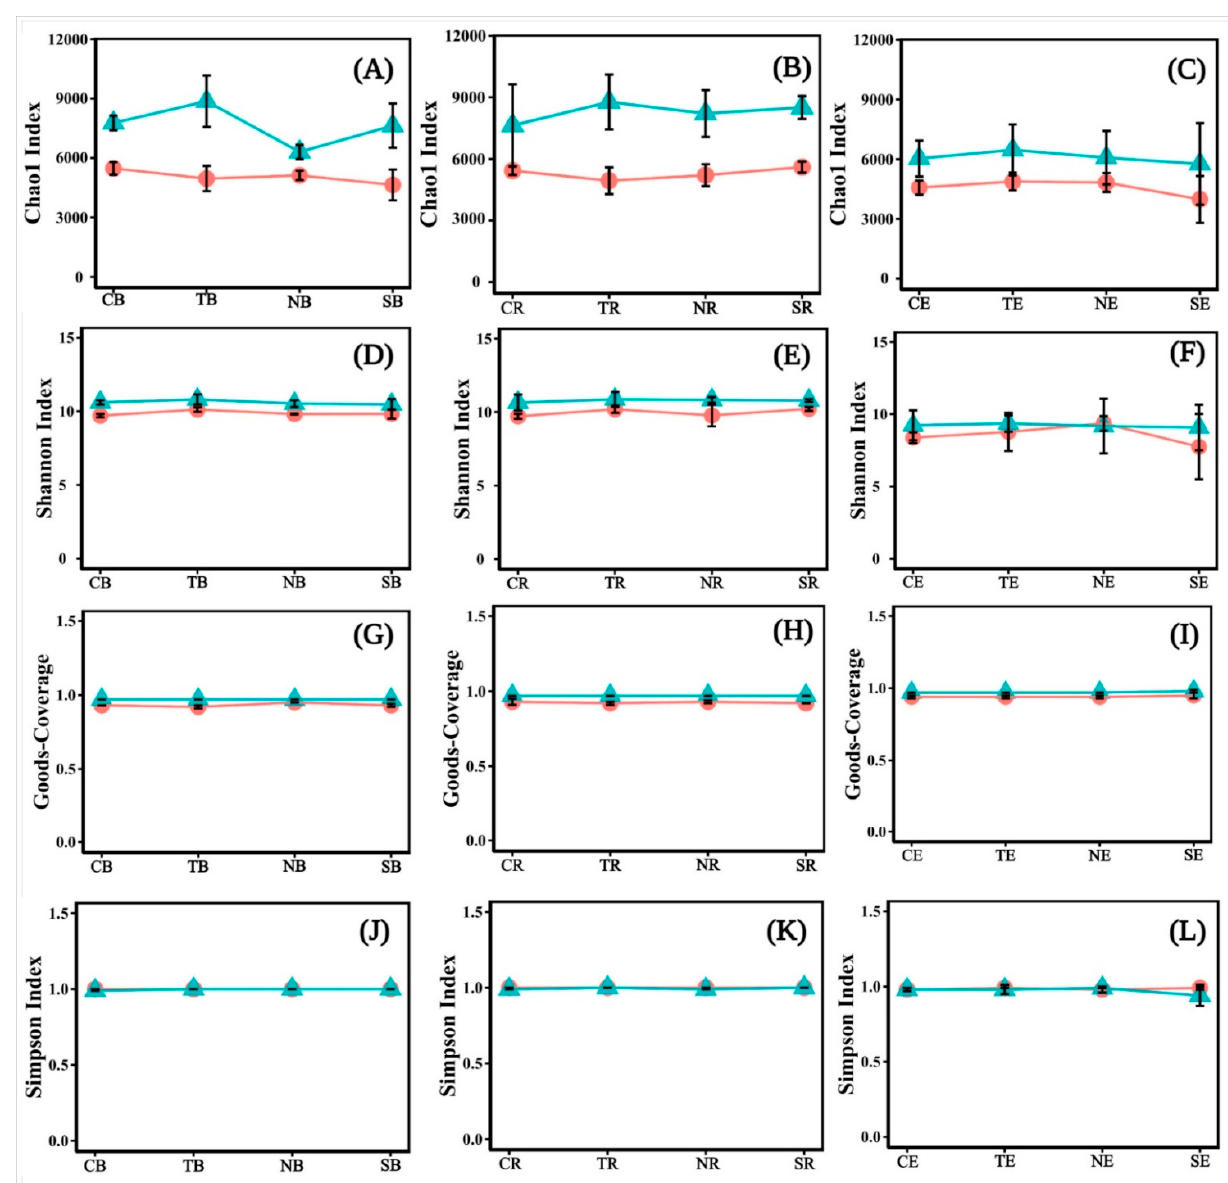
Figure 6. The diversity and richness of bacterial communities were shown with line charts for different emergence phases (T1 for early phase and T2 for late phase) within the riparian zones of the Three Gorges Dam Reservoir, China. The values of bacterial communities were shown by Chao1 Index ( A – C ), Shannon Index ( D – F ), Goods_coverage ( G – I ), and Simpson Index ( J – L ). Note: Abbreviations in the figure define as bulk soil (B), rhizosphere soil (R), endophyte (E), Cynodon dactylon (C), Hemarthria altissima (N), Salix matsudana (S), Taxodium distichum (T), the early emergence phases (the red line in the figures), the late emergence phases (the green line in the figures).